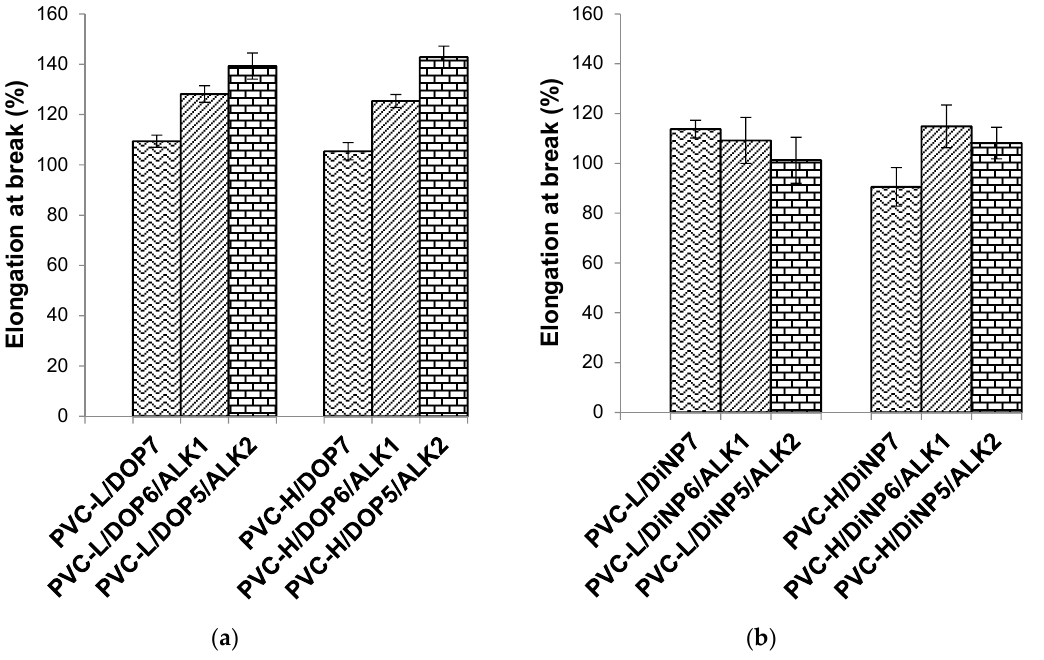
Figure 5. Effect of palm oil-based alkyd on the elongation at break of ( a ) PVC/DOP blend and ( b ) PVC/DiNP blend.